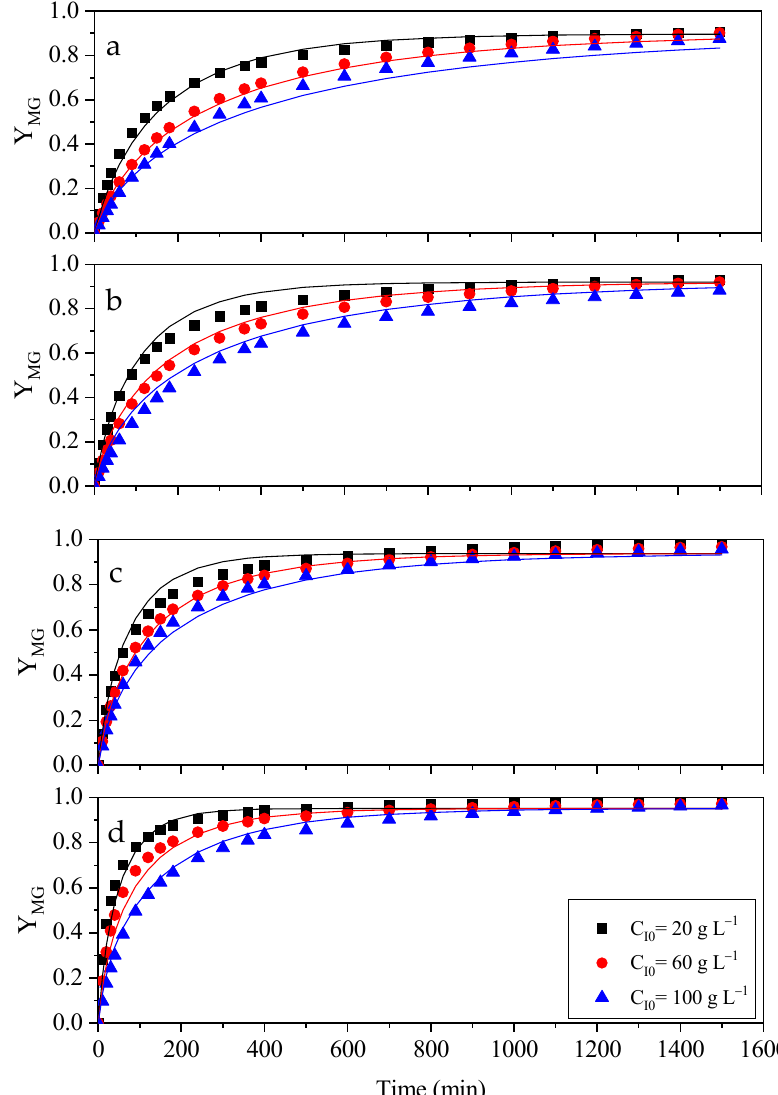
Figure 10. Esterification of ibuprofen in reactive L-L-S triphasic systems with toluene and water at zero time as cosolvents: Model 5 multivariable fit to all relevant kinetic data: ( a ) 50 °C, ( b ) 60 °C, ( c ) 70 °C and ( d ) 80 °C. Table 10. Comparison of kinetic models and parameters for triphasic systems using toluene as cosol- vent in the liquid apolar phase ([35], this work).